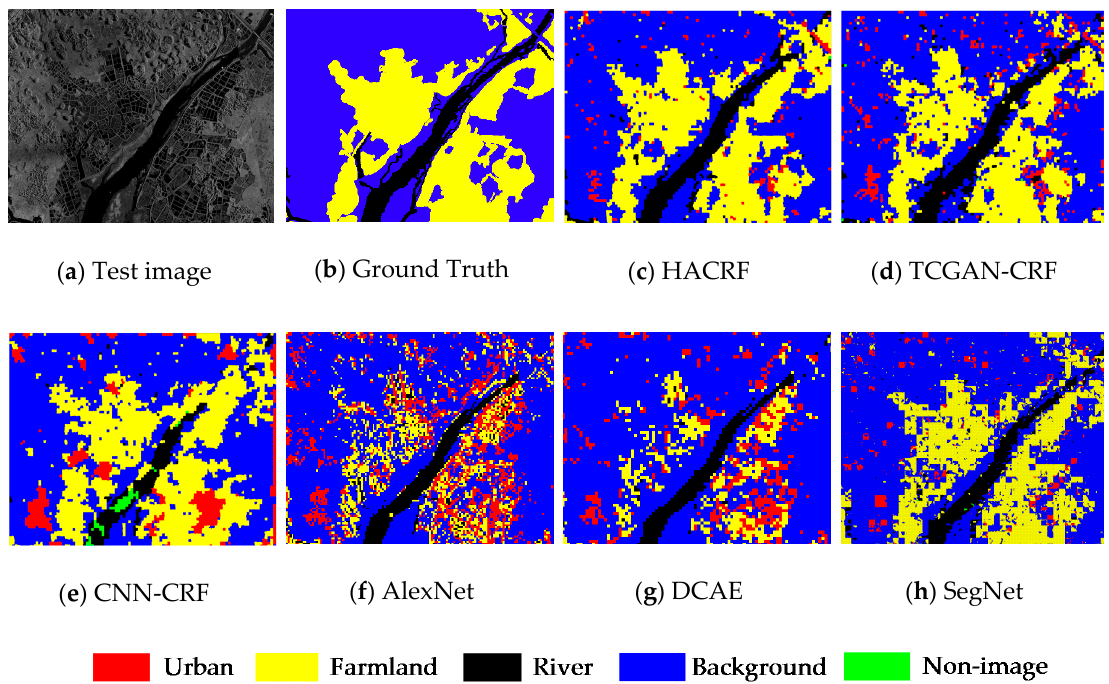
Figure 7. Segmentation results of six models on FangChengGang dataset. ( a ) Input image; ( b ) ground truth; ( c ) HACRF; ( d ) TCGAN-CRF; ( e ) CNN-CRF; ( f ) AlexNet; ( g ) DCAE; ( h )